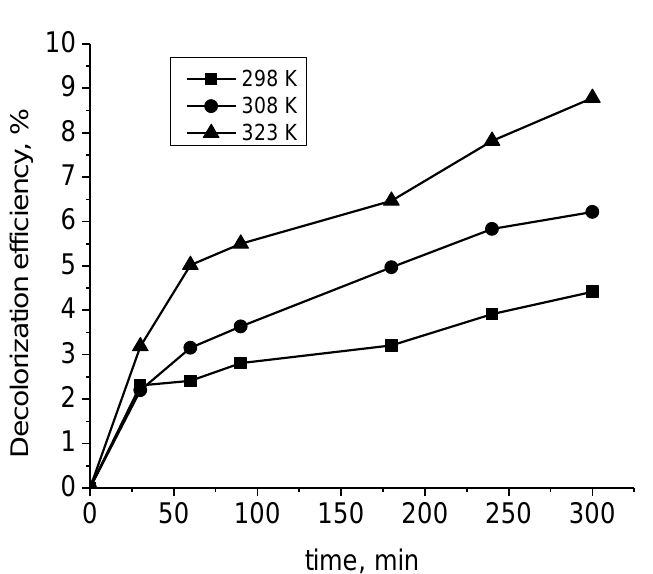
Figure 6. Effect of temperature on the discoloration of the Drimaren Rot K-7B solution at a concentration of 50 mg L −1 of 0.5 g L −1 adsorbent.